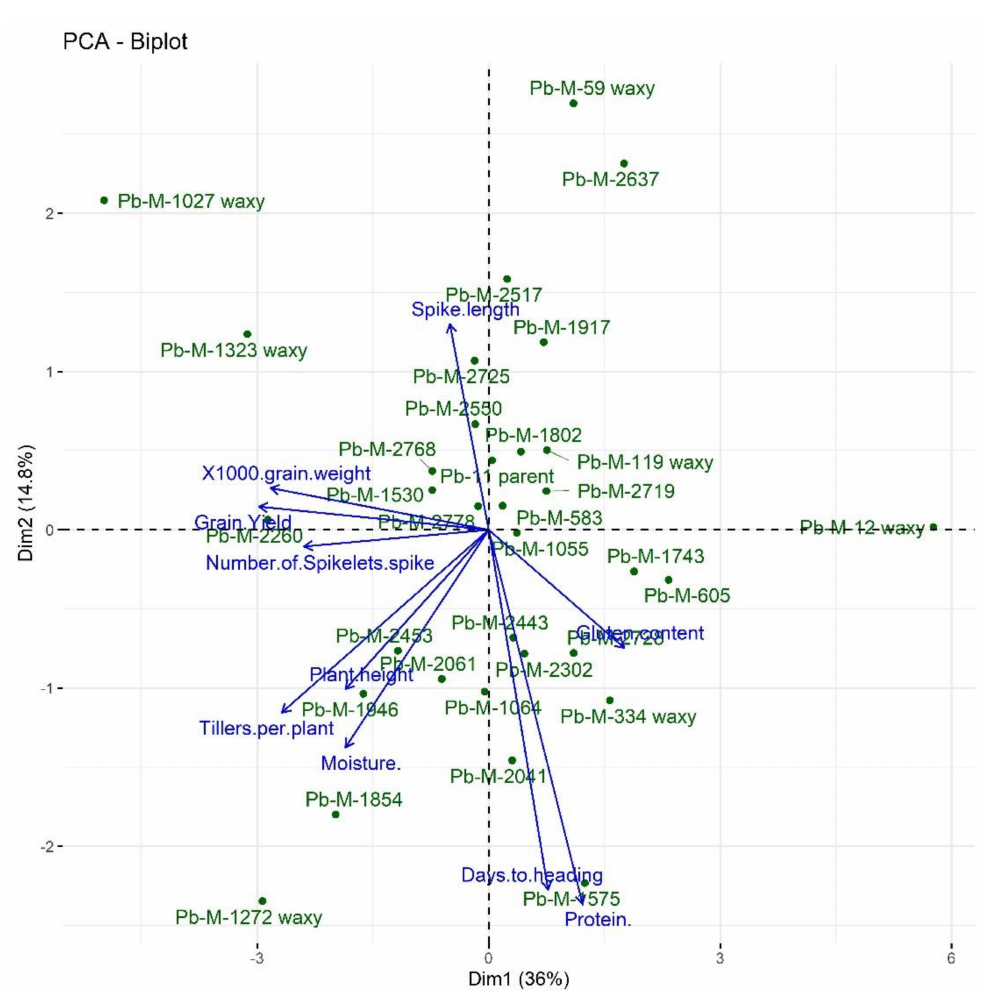
Figure 7. Genotype by trait bi-plot showing the associations among morphological and quality traits of 32 mutant lines and the wild type in M 7 and M 8 generations at the NIBGE